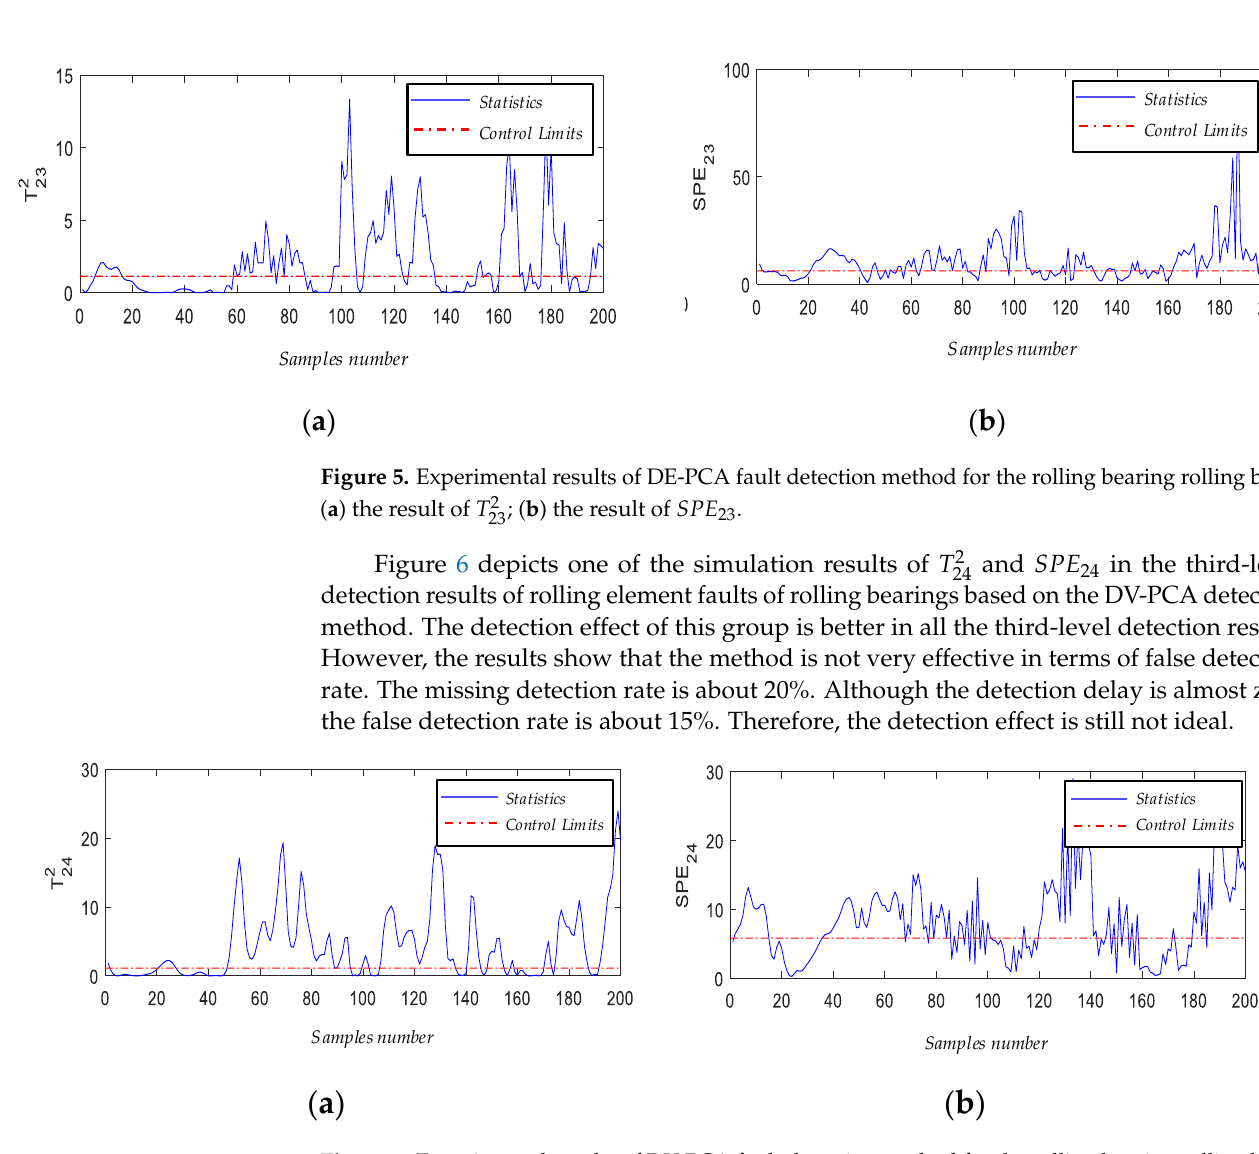
Figure 6. Experimental results of DV-PCA fault detection method for the rolling bearing rolling body: ( a ) the result of T 2 ; ( b ) the result of SPE 23 .